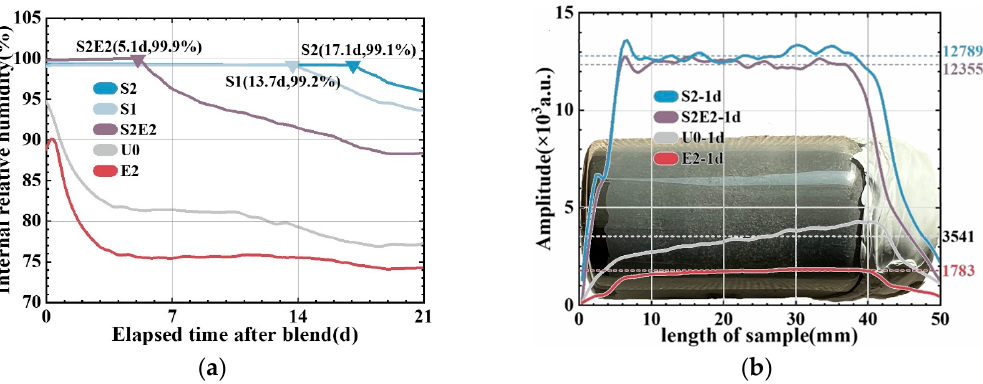
Figure 6. Relative humidity change in hardened UHPC matrix. ( a ) RH change with time. ( b ) Water distribution in the 1 d matrix.